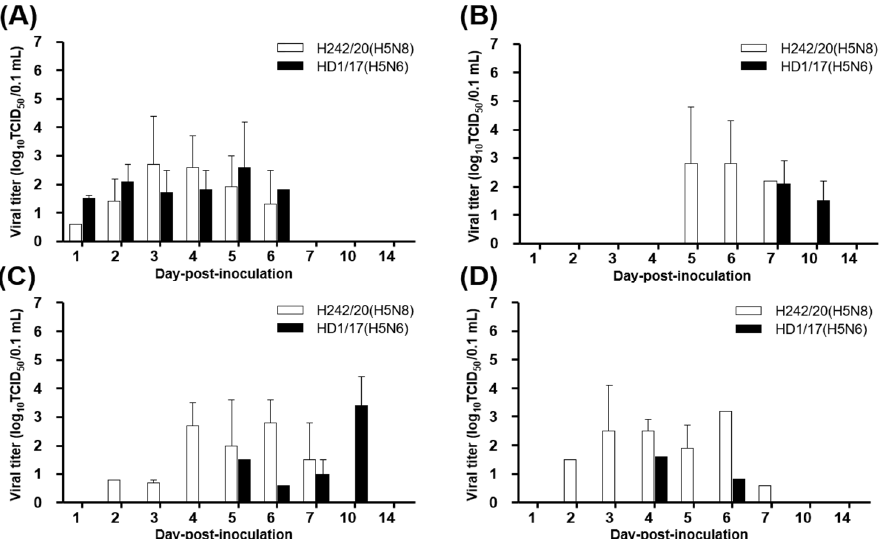
Figure 3. Virus isolation from oropharyngeal (OP) ( A , B ) and cloacal (CL)( C , D ) swab samples of virus-exposed ducks. Ducks ( n = 5) were intranasally inoculated with 10 6 EID 50 /0.1 mL H242/20(H5N8) or HD1/17(H5N6) ( A , C ). For the contact group, naïve ducks ( n = 3) were co- housed with H242/20(H5N8)- or HD1/17(H5N6)-infected ducks ( B , D ). Viral titers are shown as the mean ± standard deviation.